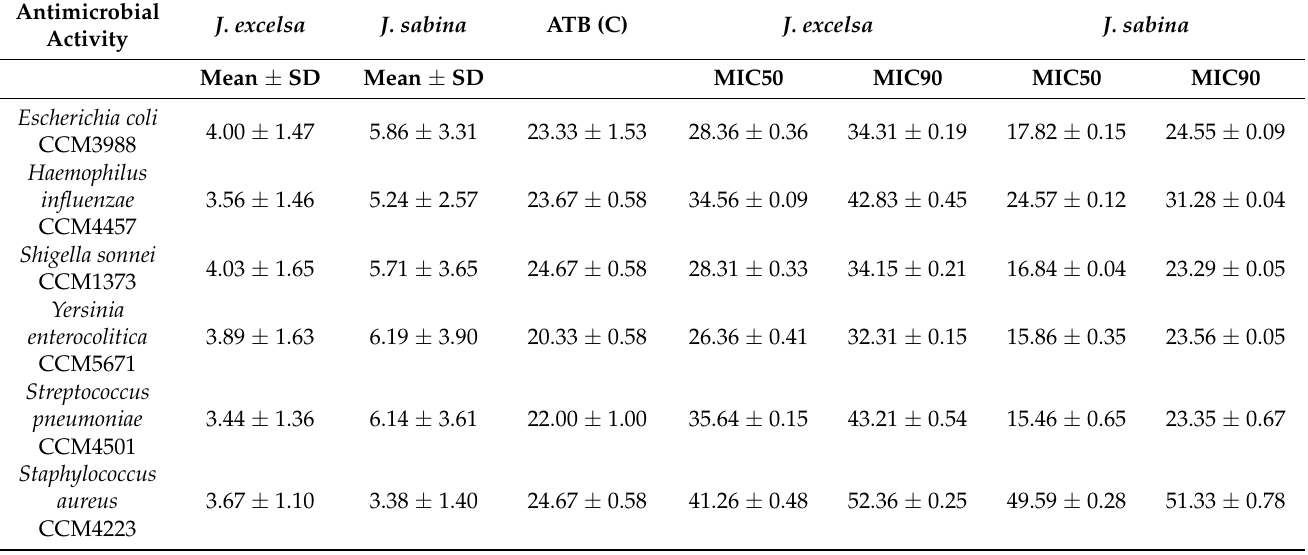
Table 8. Antimicrobial activity of juniperus with the disc diffusion method in mm and the microdilution broth method in µ L/mL.